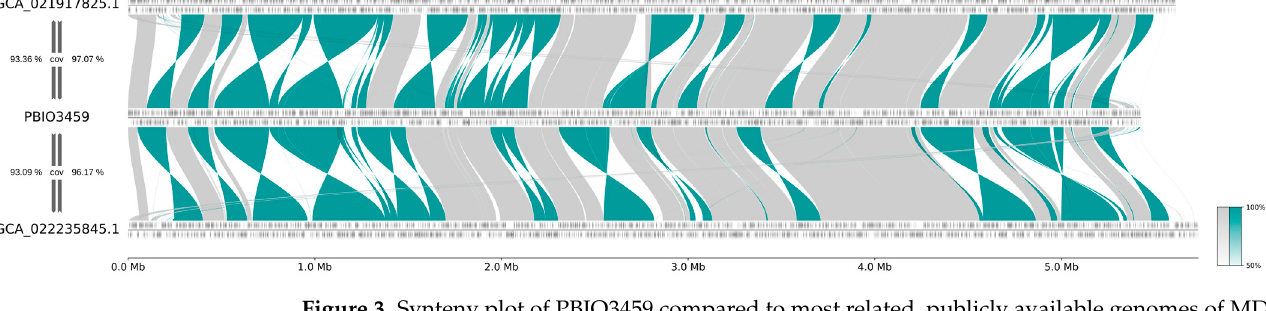
Figure 3. Synteny plot of PBIO3459 compared to most related, publicly available genomes of MDR K. pneumoniae ST20 strains. Genomes were selected based on a Kleborate resistance score ≥ 1 and most shared k-mers using a Mash-based approach. The synteny plot shows a large extent of similar (gray) or inverted regions (teal) of the draft assembly PBIO3459 and the selected genomes. cov: genome coverage.